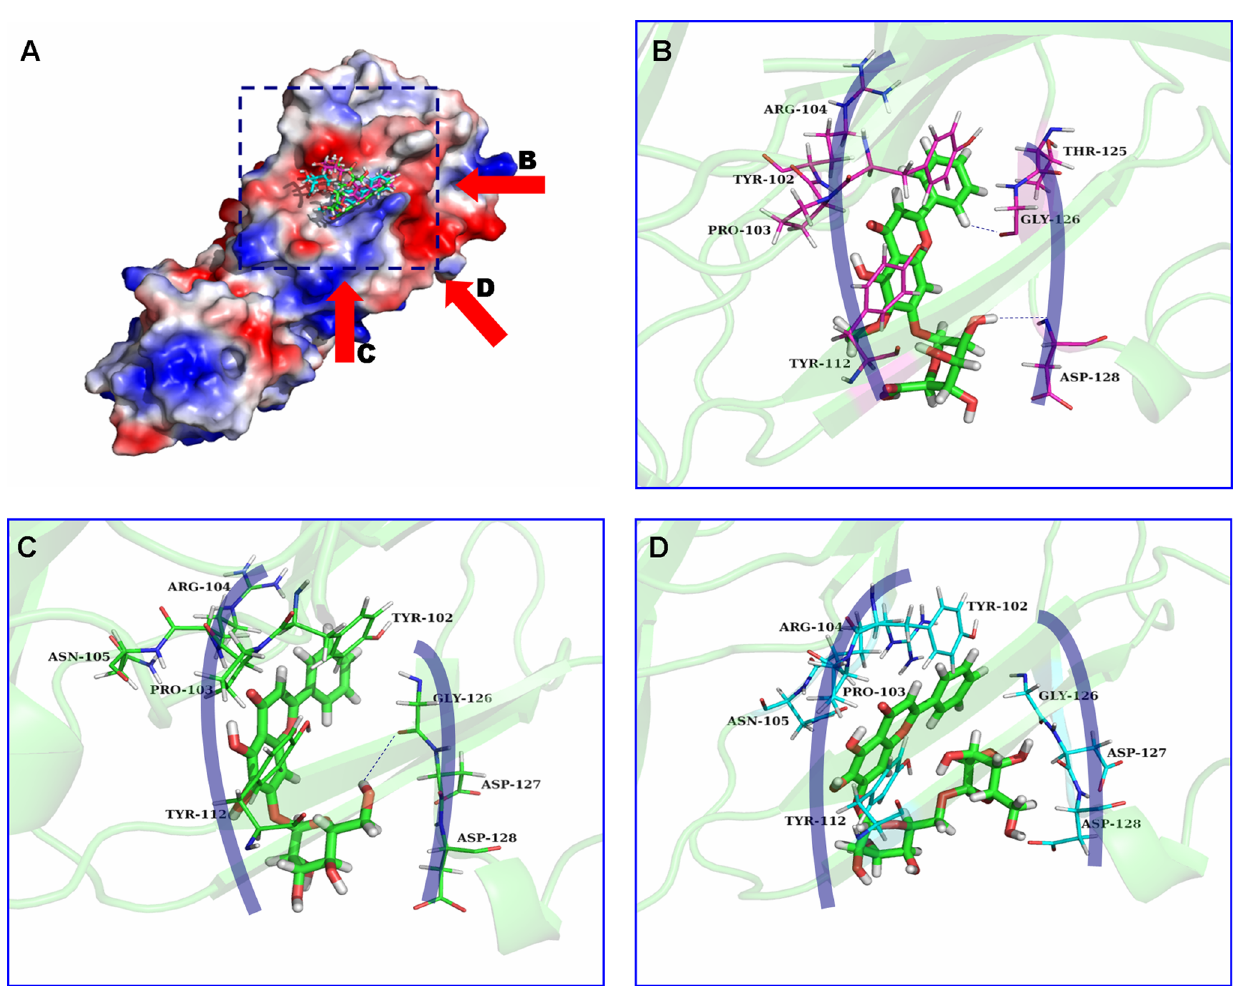
Figure 3. (A) Overview of the a -HL: compound complexes based on MD simulation. The arrows indicate the predicted binding mode of oroxylin A 7-O-glucuronide (OLG) with a -HL (B), oroxin A (ORA) with a -HL (C), and oroxin B (ORB) with a -HL (D). The shadow region represents the left region (L) and right region (R) of the binding cavity.